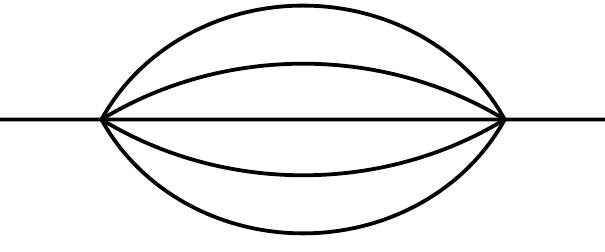
Figure 1 . The four-loop banana graph that is related to the Hulek-Verrill